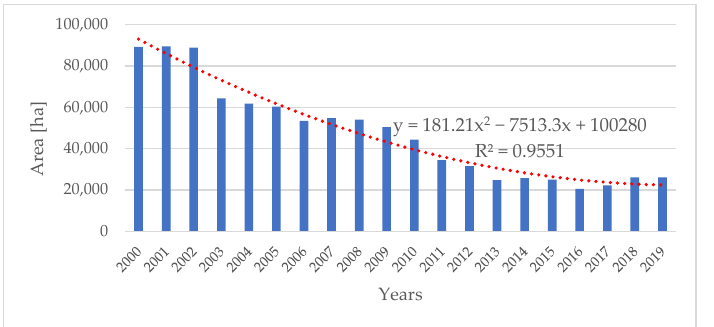
Figure 1. The actual general area of potato cultivation and the tendency of changes in this area in the southeastern part of Poland, 2000 – 2019.